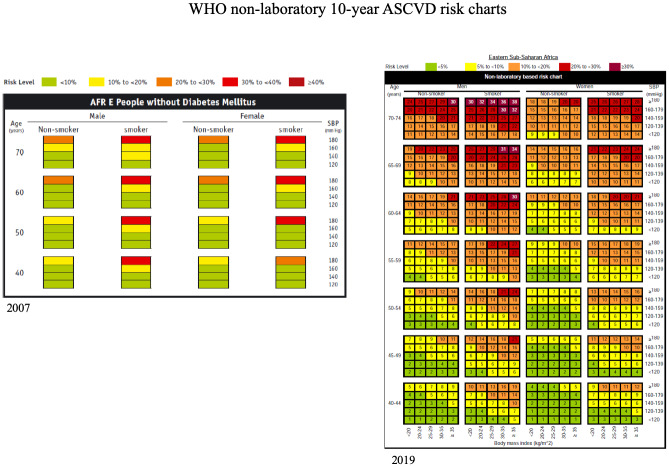
WHO CVD risk comparison charts for patients without diabetes.Left, 2007 “AFR E” field guidelines, stratified by Age, sex, SBP and smoking status. Right, 2019 “East SSA,” with further stratification by BMI.